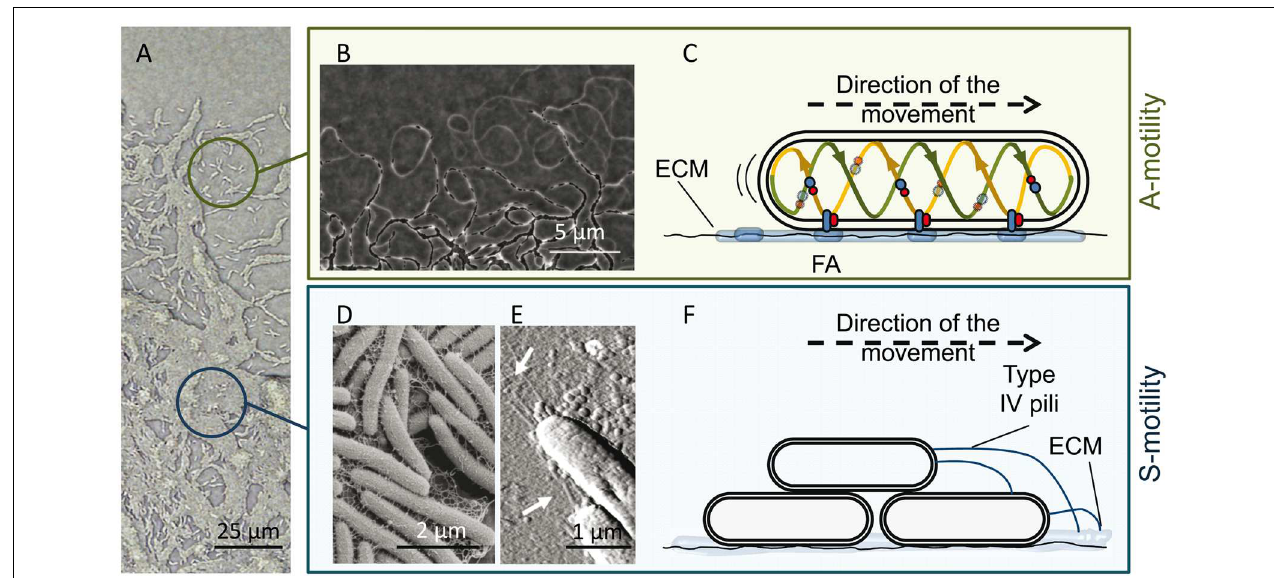
FIGURE 2 | M. xanthus A and S motility. (A) The edge of a M. xanthus swarm. Upper circle, single cells (with A-motility); bottom circle, group of cells (with S-motility). (B) Phase contrast microscopy revealing A-motility-mediated trails observed at the leading edge. Migration of other cells through these trails promotes the formation of dense regions of aligned cells and favors intimate cell–cell contacts. (C) Proposed focal adhesion (FA) model of gliding motility. The cytoplasmic, inner membrane and periplasmic components of the Agl–Glt motility protein complex move along a helical track (provided by cytoskeletal proteins) within the cells. After this trafficking, the complex engages the outer components and then the entire complex adheres to the substrate via ECM slime, forming an FA that allows the machinery to push. The protein complexes translocate along the cellular track, pushing the cell forward. (D,E) Components of the S-motility system, fibrils and type IV pili (T4P). (D) Scanning electron microscopy of the meshwork of fibrils that maintain cellular cohesion. (E) Atomic force microscopy of T4P localized at the leading cell pole. (F) Proposed model for S-motility. T4P anchors to the EPS present on neighboring cells and propels the cell by cycles of extension, attachment, and retraction. The pictures of the phase bright A-motility trails (B) and T4P (E) were adapted from Gloag et al. (2015) with permission of the authors, and from Pelling et al. (2005) with permission; copyright (2005) National Academy of Sciences, USA. Micrograph of the fibril material was kindly provided by L. J.